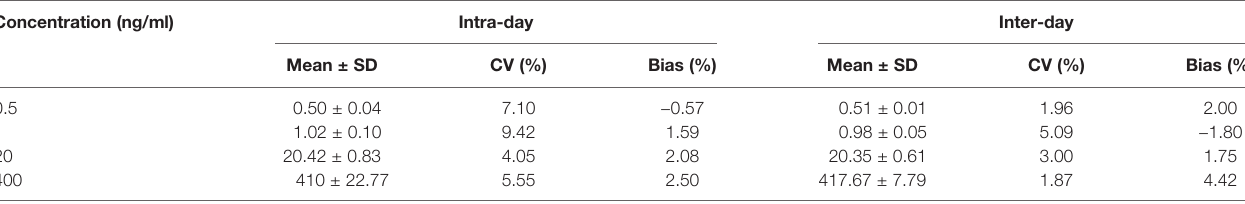
CV, coef fi cient of